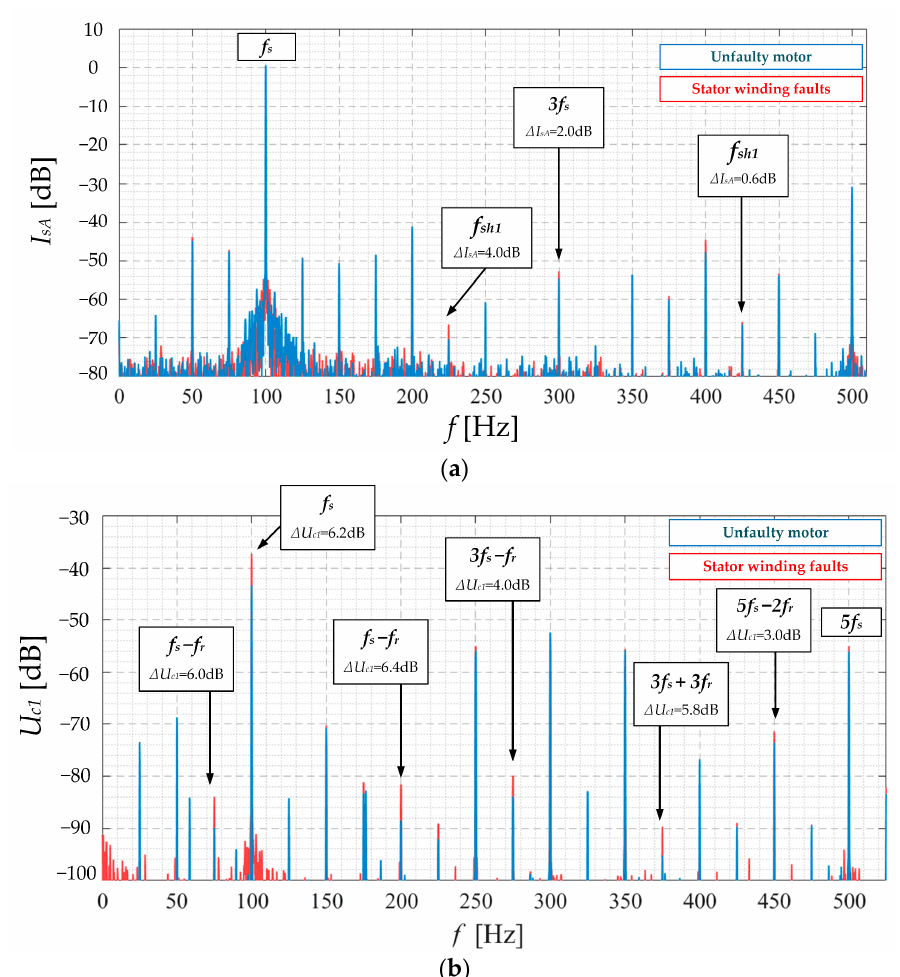
Figure 1. Analysis of the phase current ( a ) and axial flux ( b ) spectrum during inter-turn short-circuits.